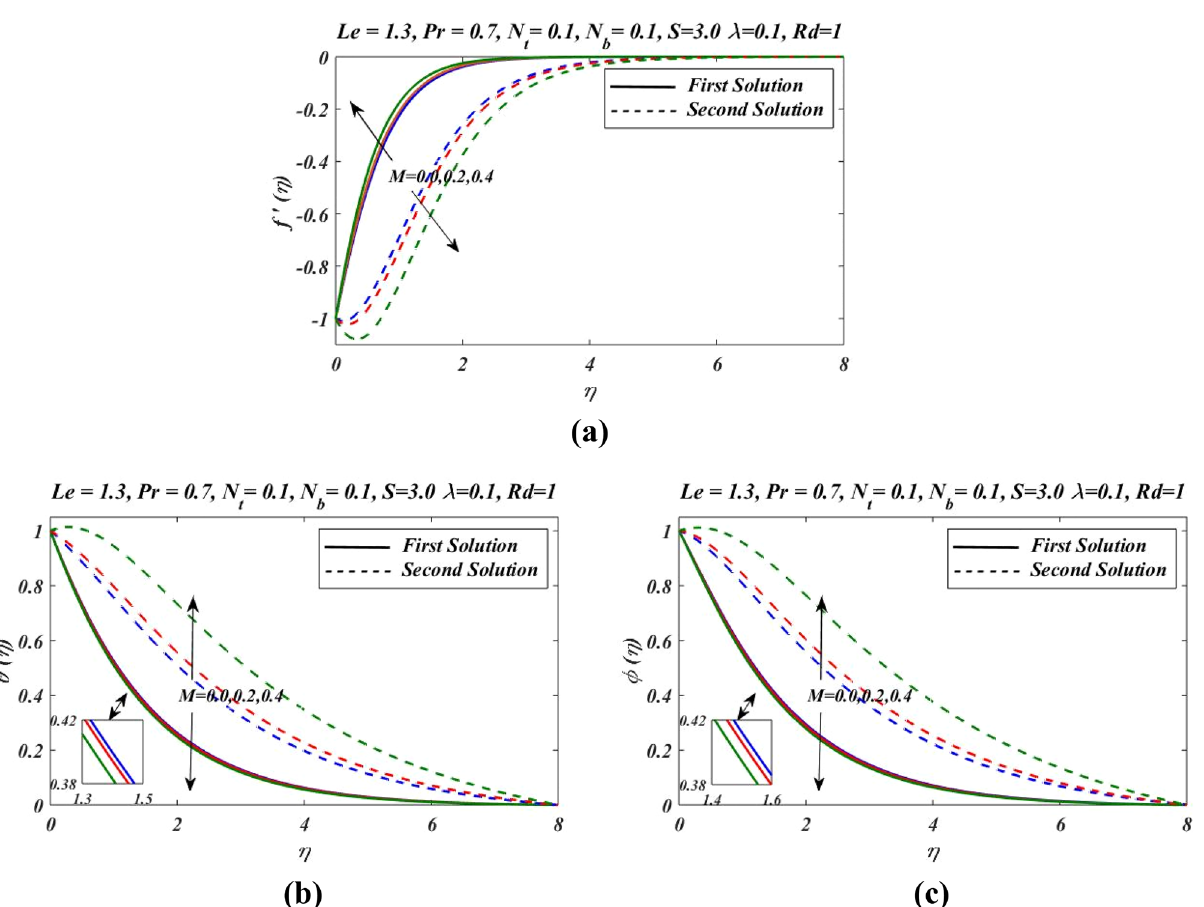
Figure 6. Outcomes of M on ( a ) velocity, ( b ) temperature and ( c ) nanoparticles volume